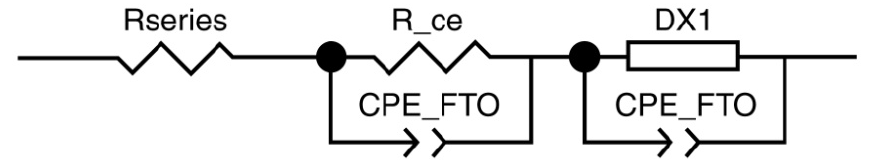
Figure 8. Transmission line model used for the interpretation of the measured data at 0.4 or 0.5 V, depending on the selected sensitizer.